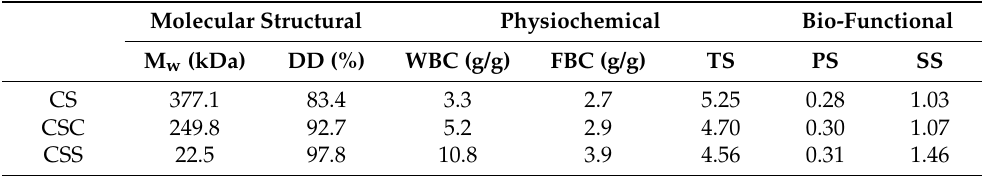
Table 3. Raw data of chitosan chemistry performance